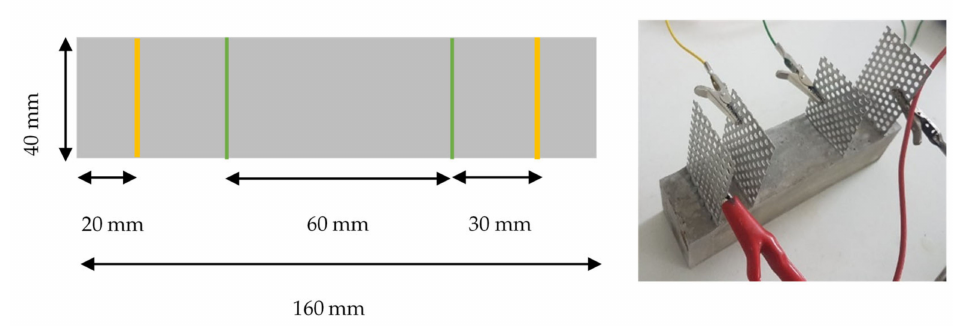
Figure 1. Four-probe setup for electrical resistivity measurements. Outer electrodes supplied a DC = 10 V, and inner electrodes measured the change in